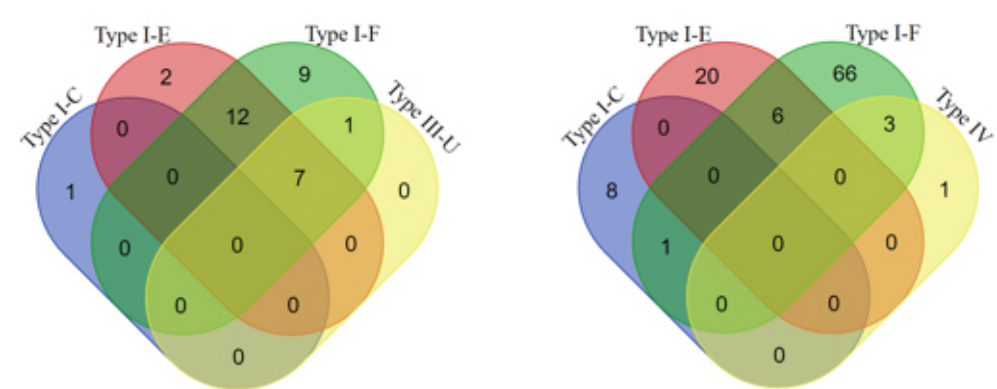
Figure 2. Venn diagrams of CRISPR/Cas system type distribution for CriePir ( left ) and reference ( right ) P. aeruginosa isolates.